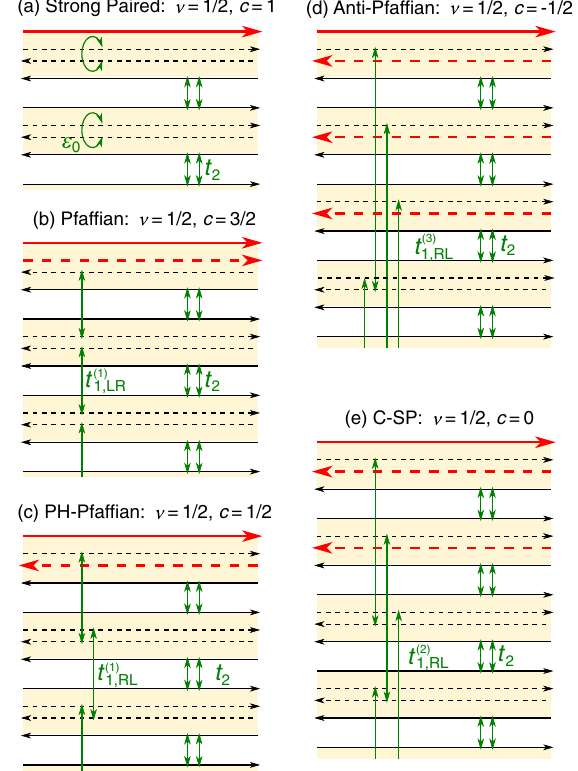
FIG. 3. Schematic diagrams for quantum Hall states at ν ¼ 1 = 2 . Each shaded region depicts a wire at the pairing transition with right- and left-moving Majorana modes (dashed lines) as well as right- and left-moving charge modes (solid lines) describing ϕ R=L ¼ φ (cid:3) m θ ¼ 2 . The charge modes are coupled ρ ;i ρ ;i with m ρ ;i by t 2 in Eq. (46), leaving a single unpaired chiral charge mode on each edge. The Majorana modes are coupled in different ways as described in the text, resulting in topologically distinct states with different numbers of chiral Majorana edge modes. In panel (d), C-SP refers to the particle-hole conjugate of the strong-paired